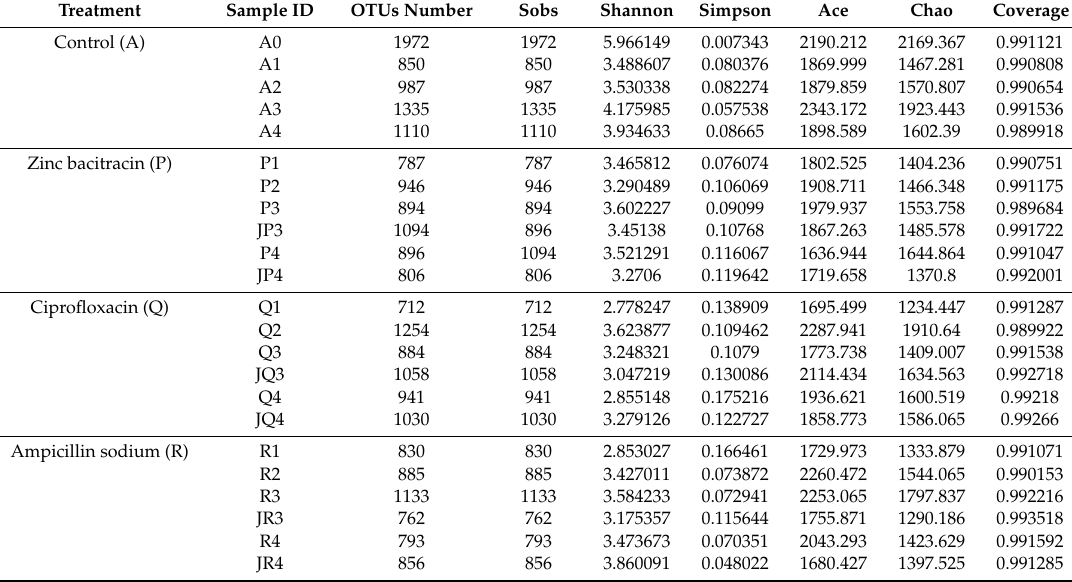
Table 3. Alpha diversity indices of microbial